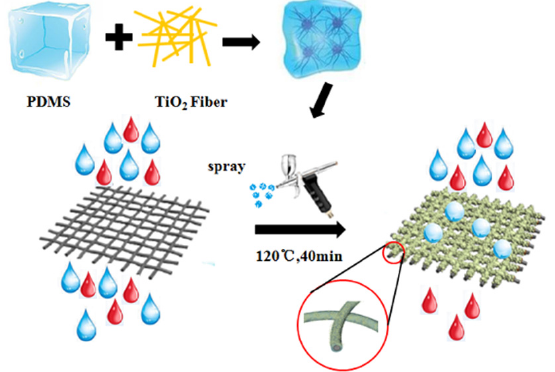
Figure 1. Sketch of preparation of the superhydrophobic stainless steel mesh.